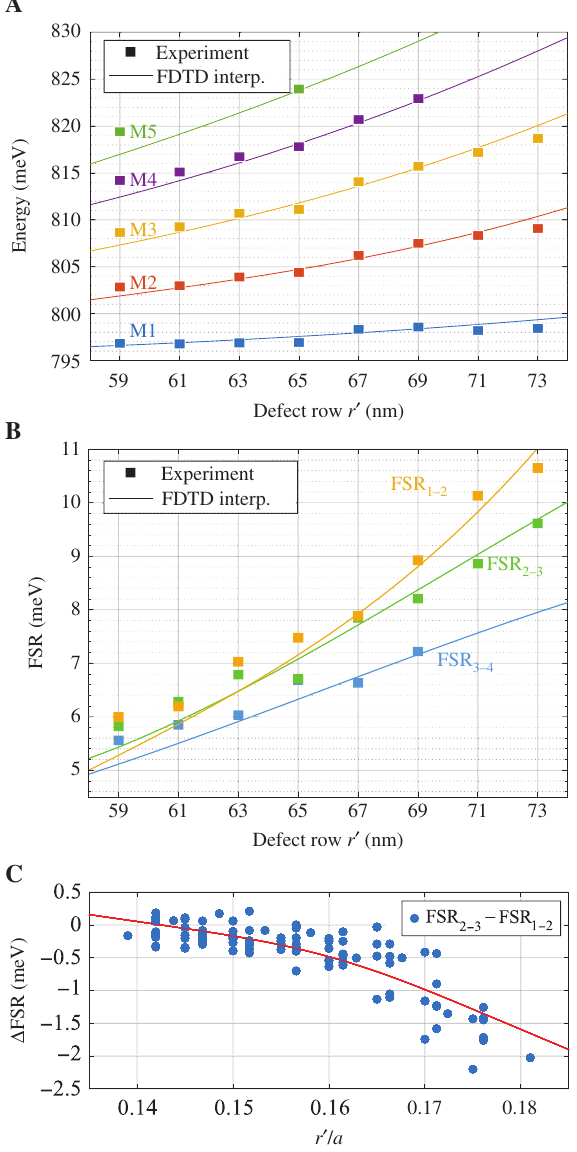
Figure 2: Resonance energy and free spectral range as a function of the line defect radius r ′ . (A) Resonance energy as a function of the line defect radii, r ′ , for the first five modes. Solid lines represent a polynomial interpolation of the FDTD data (calculated for r ′ from 58 nm to 74 nm in steps of 2 nm), while squares represent the RS measured values. (B) Free spectral range as a function of r ′ , for the first four modes. Again, solid lines represent a polynomial interpolation of the FDTD data, while squares represent the RS measured values. (C) Statistics = FSR of the FSR mismatch Δ FSR – FSR for the first three i , j , k j − k i − j resonances as a function of the r ′ / a ratio over the entire poll of 106 measured devices. The red line is a guide to the